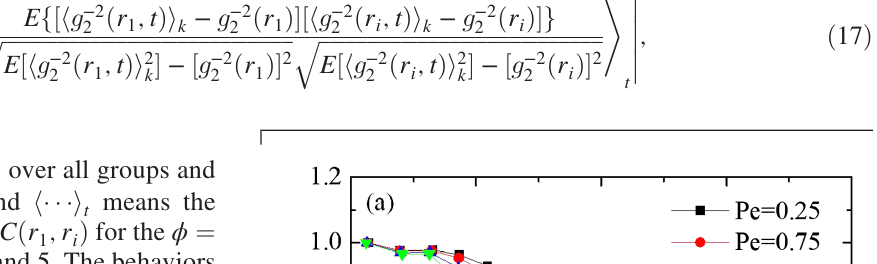
FIG. 5. (a) C ð r 1 ; r at Pe ¼ 0 . 25 , 0.75, 2.5, and 5. In this case, C ð r 1 ; r statistically noisy at C ð r 1 ; r effective zero for C ð r 1 ; r simulated points in the shear-thinning regime. The solid line denotes the relation of ξ ¼ 1 . 23 ξ